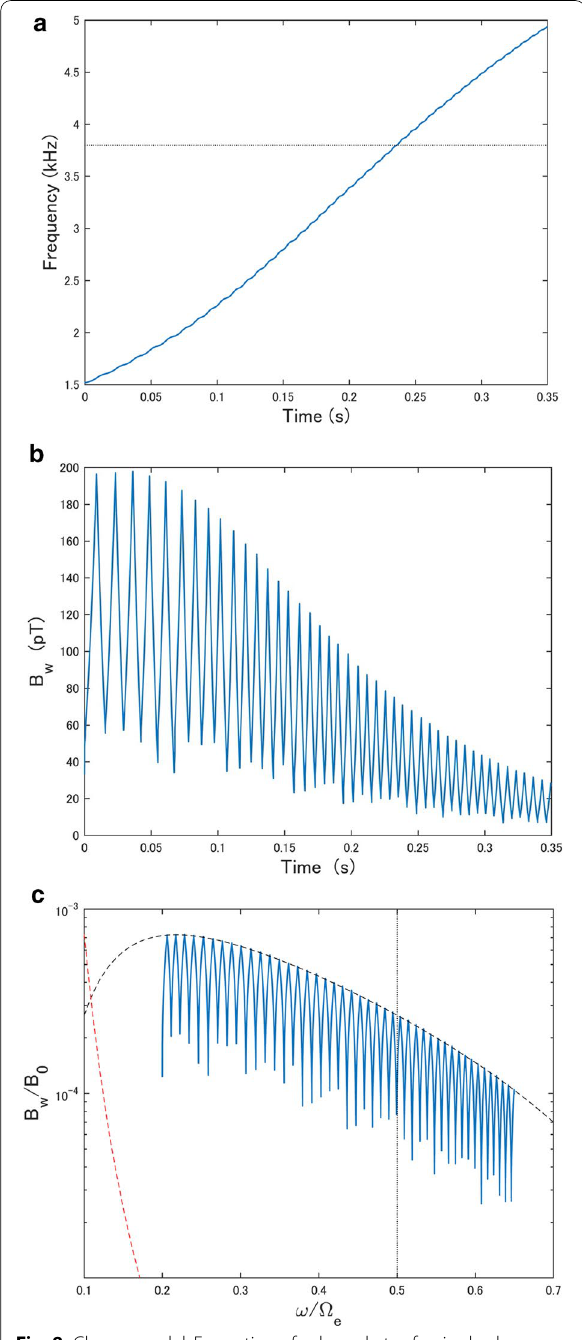
Fig. 8 Chorus model. Formation of sub-packets of a single chorus emission at the equator with V